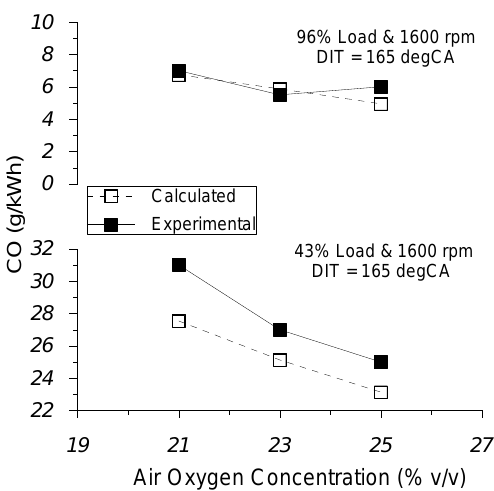
Figure 5. Comparison between experimental and computed specific CO concentration as a function of “inlet-air oxygen ratio”, for N = 1600 rpm and “a” = 20%, at 43% and 96% of engine rated load.